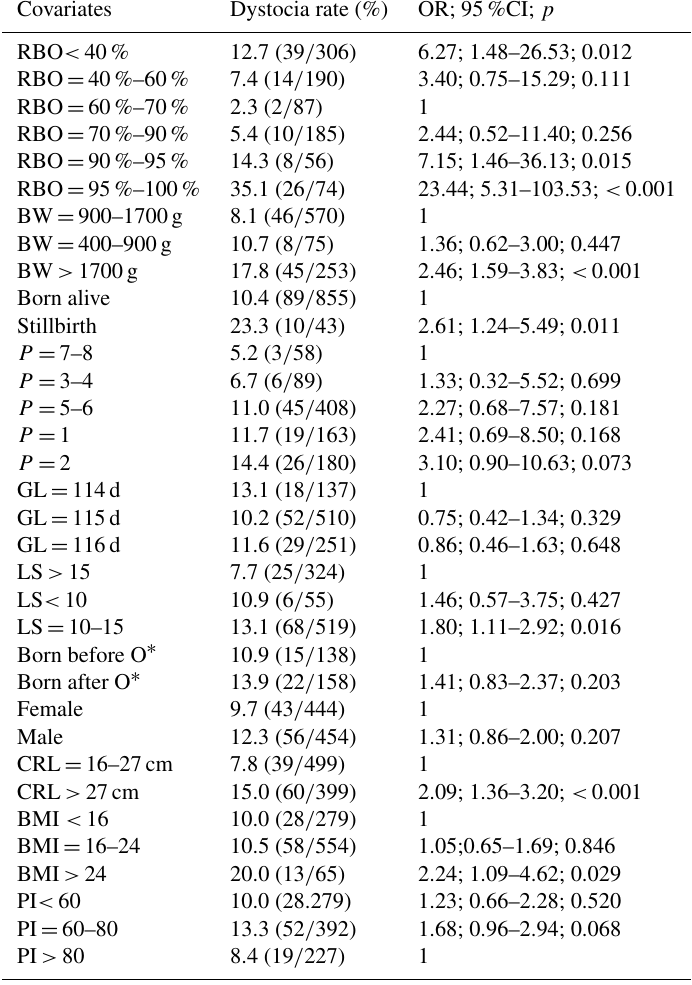
Table 2. Univariate analysis of risk factors for dystocia in swine at piglet level ( n =